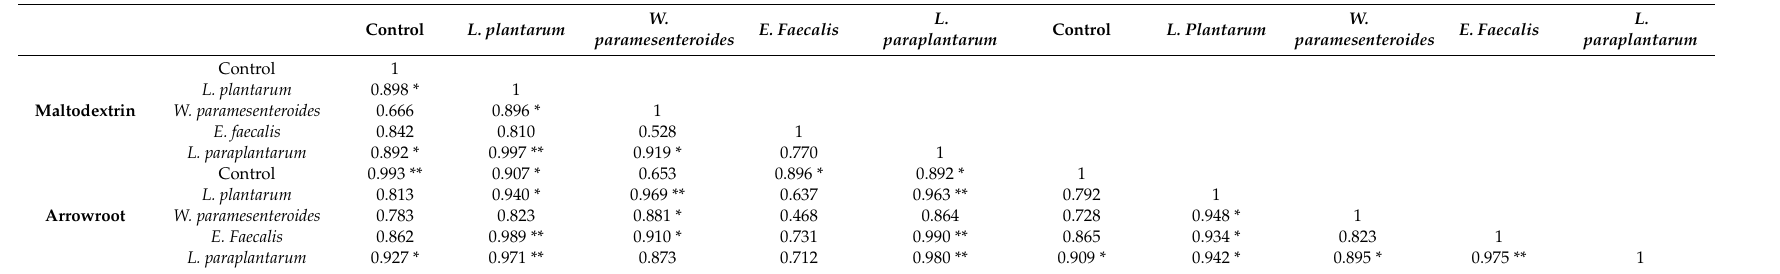
Table 4. Pearson’s correlation coe ffi cients between the encapsulated maltodextrin and arrowroot bacteria.